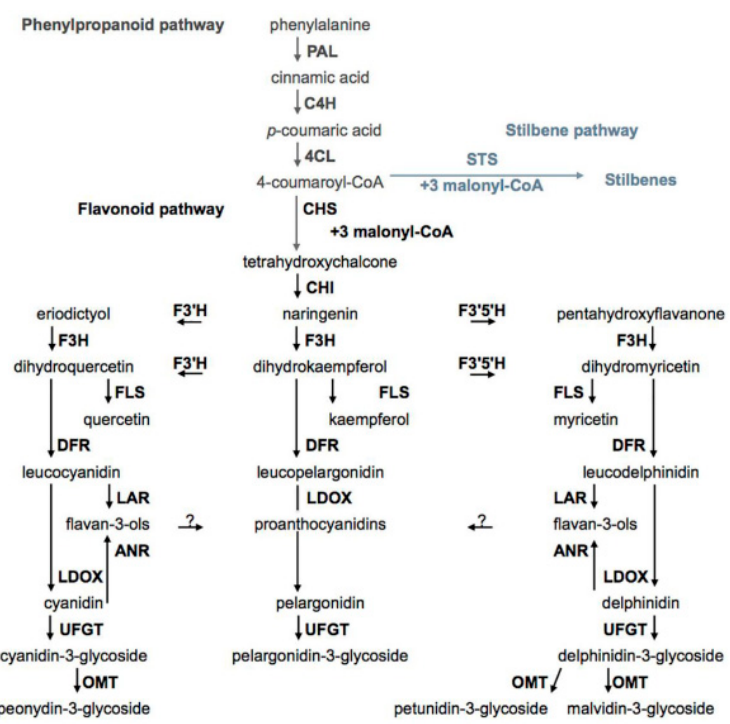
Figure 7. Biosyntheses of phenolic compounds. PAL—phenylalanine ammonia-lyase, C4H—